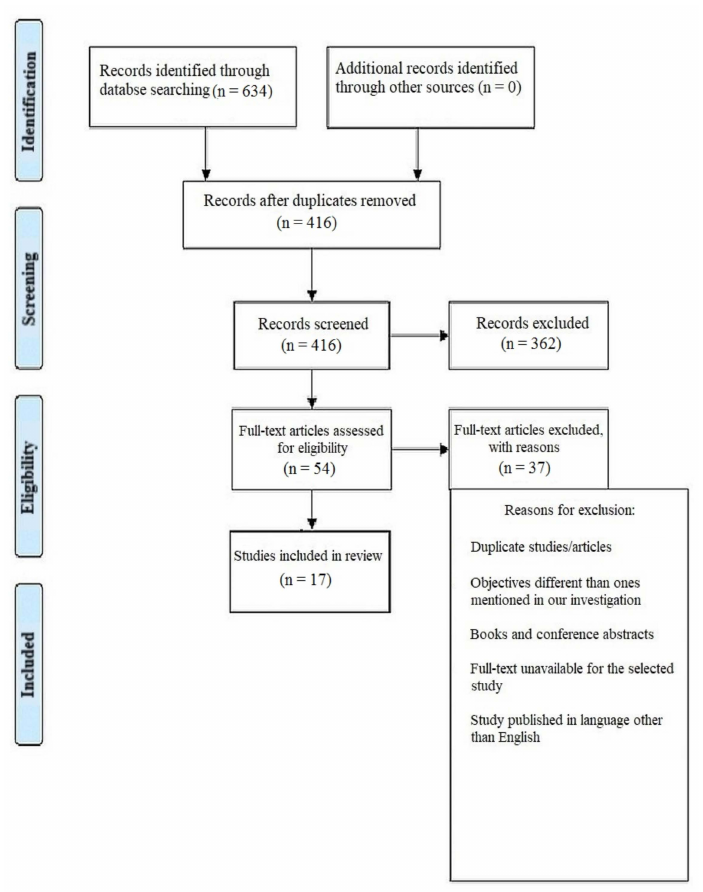
Figure 1. Representation of selection of articles through PRISMA